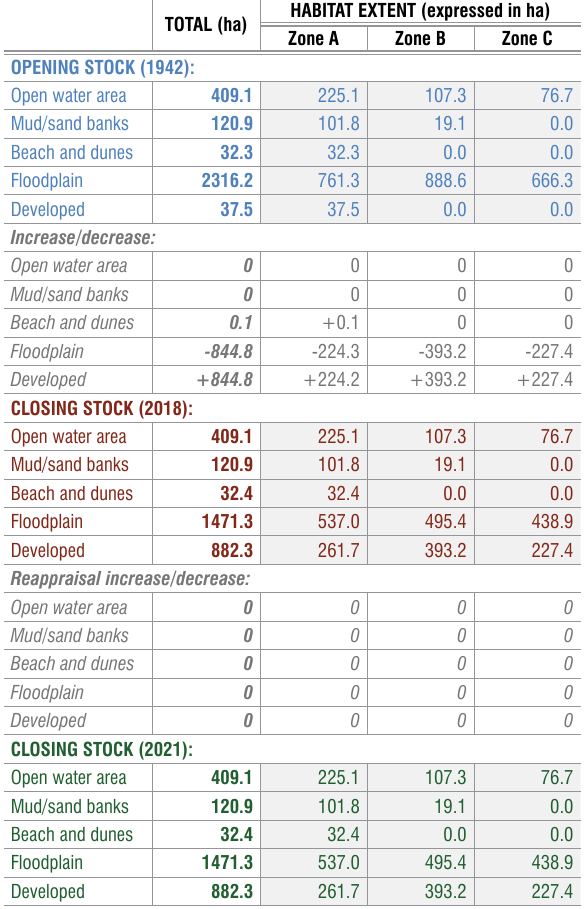
Extent account for abiotic habitat in the Swartkops Estuary